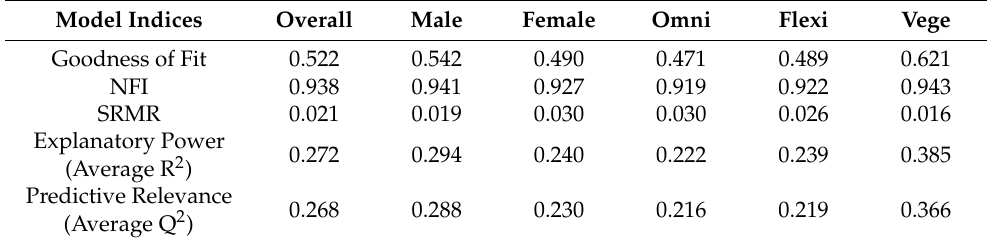
Table 5. Goodness of Fit, Explanatory Power, and Predictive Relevance